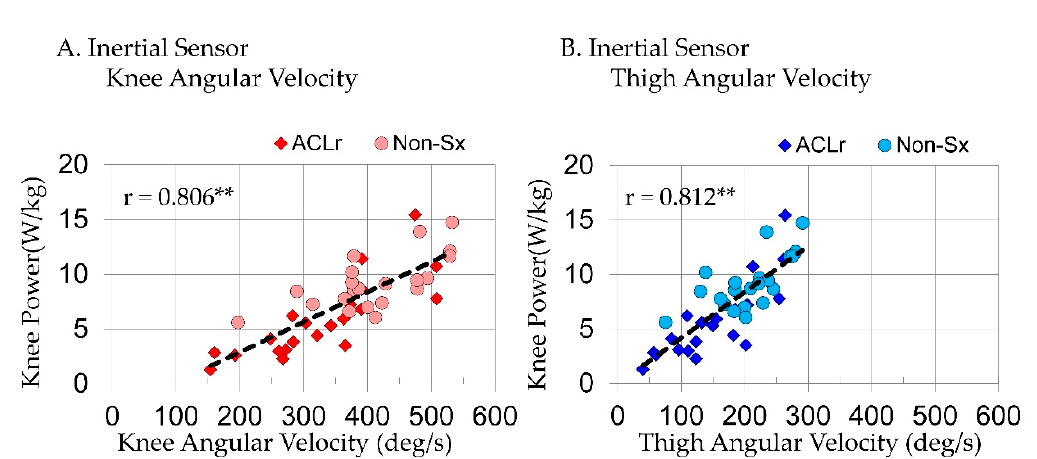
Figure 4. The relationship between peak knee power absorption and ( A ) peak knee angular velocities and ( B ) peak thigh angular velocities measured with inertial sensors in the reconstructed (ACLr) and nonsurgical (Non-Sx) limb; ** p < 0.001.